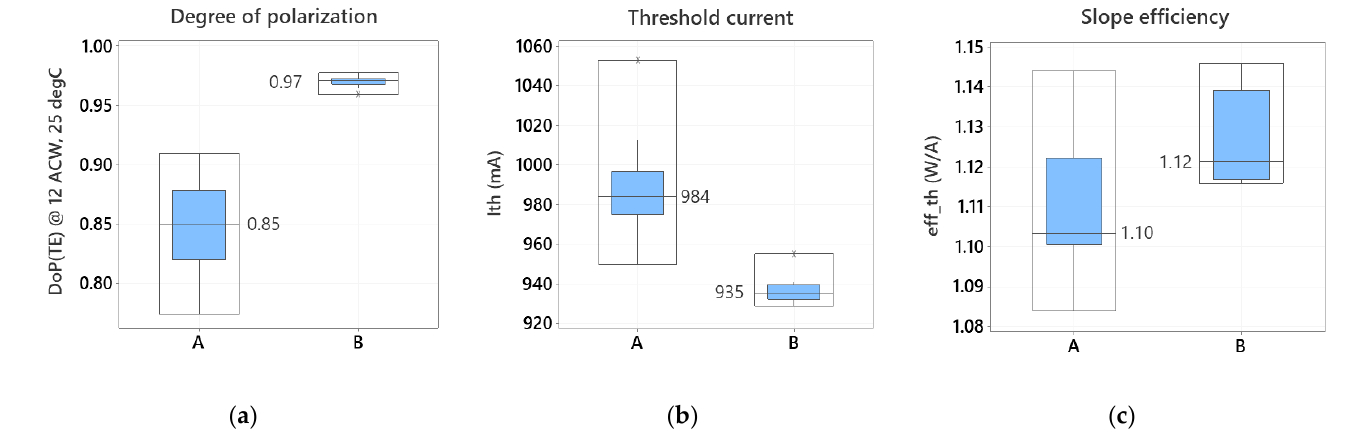
Figure 8. Measured effects of stress-induced DoP reduction on functional characteristics of two sets of HPLD mounted on carriers. Set A represents 10 high-stressed HLPD while set B represents 10 low-stressed HLPD. ( a ) Box plots of measured DoP; ( b ) box plots showing threshold current increase from B to A; ( c ) box plots showing slope efficiency decrease from B to A.